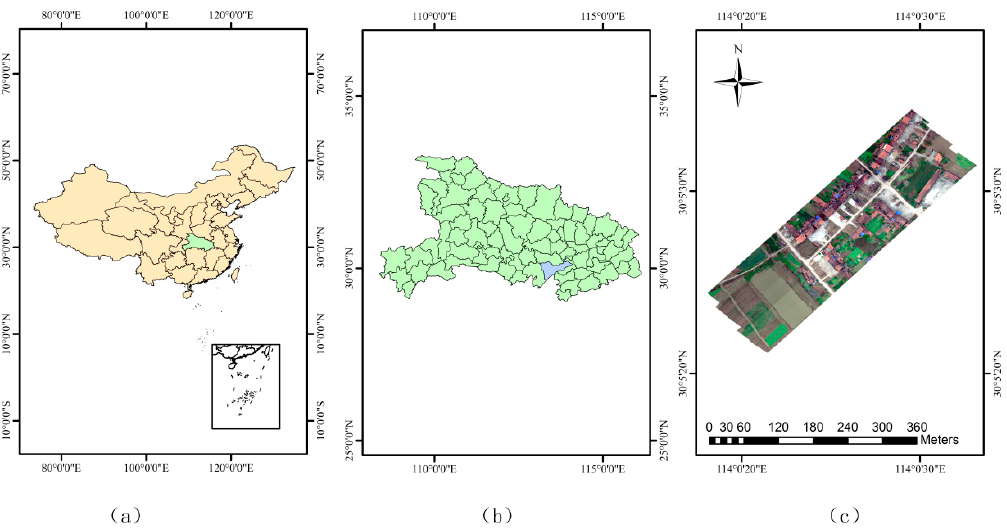
Figure 4. ( a ) The location of Hubei Province in China. ( b ) Administrative area map of the city of Honghu in Hubei Province. ( c ) The study site.